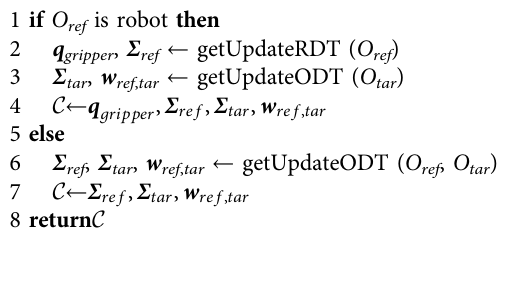
Algorithm 2. Pseudocode of the getContextInformation